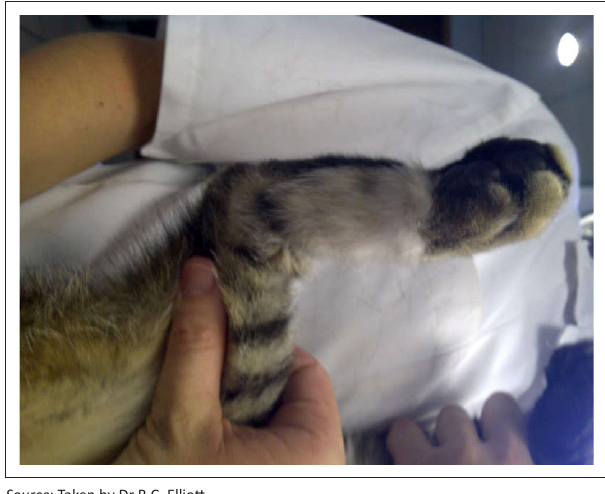
FIGURE 1: Hair growing in the opposite direction to the surrounding hair.